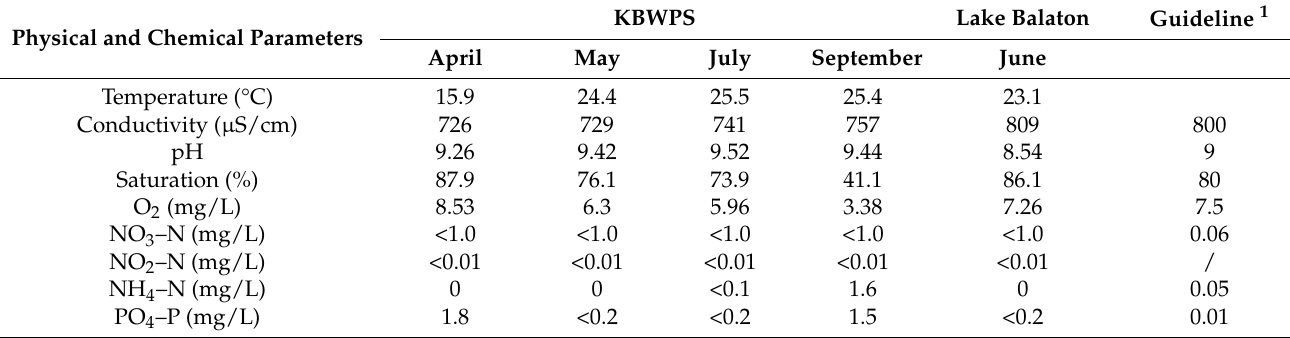
Table 3. Water quality parameters of the Kis-Balaton Water Protection System (KBWPS) and Lake Balaton during the investigated period of